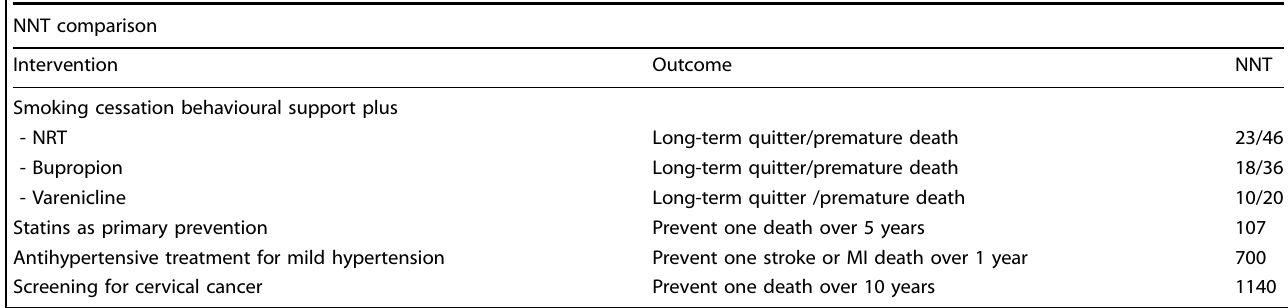
Table 2. Comparison of number needed to treat ( NNT ) to prevent one death. Smoking cessation medication is usually used for 3 – 6 months, while statins or antihypertensive medication might be used throughout